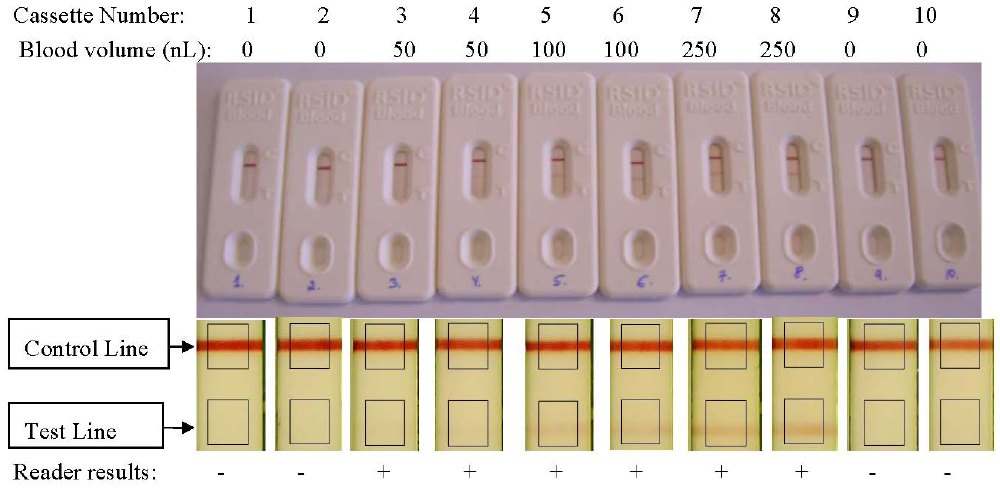
Figure 2. Results of RSID™ Blood and RSID™ Reader Experiments. Results of two replicates for each analyzed blood volume from one Reader are shown. Cassette number and calculated volume of blood added to each cassette are shown (top). Digital camera capture of cassettes and RSID™ Reader images are shown below, respectively. volumes analyzed indicated above the images of the corresponding RSID™